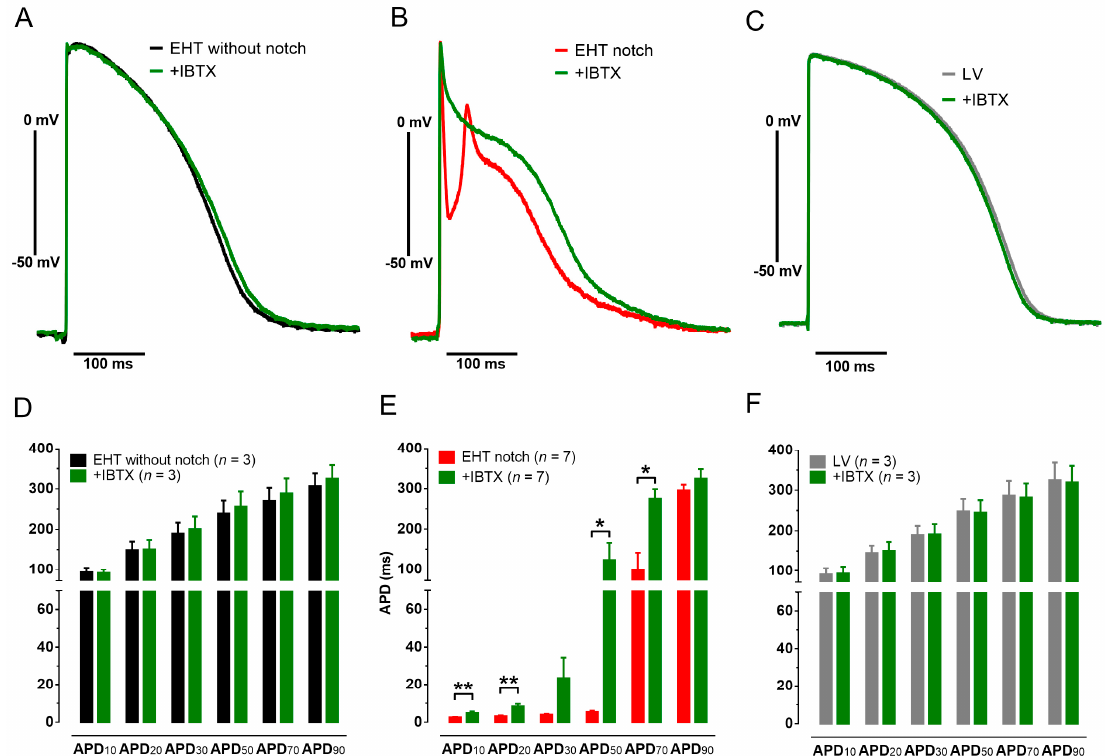
Figure 3. Effects of iberiotoxin (IBTX) on action potentials (APs) in C25 engineered heart tissue (EHT) and in human left ventricular tissue (LV). Original AP recordings before and after exposure to IBTX (100 nM, green) in EHTs with ( A ) and without ( B ) notch/oscillations from cell line C25 and in LV ( C ). Mean values of AP duration at different levels of repolarization (APD 10-90 ) before and after exposure to IBTX (100 nM) in EHTs with ( D ) and without ( E ) notch in cell line C25 and in LV ( F ). Mean values ± SEM, * p < 0.05, ** p < 0.01, paired Student’s t test.